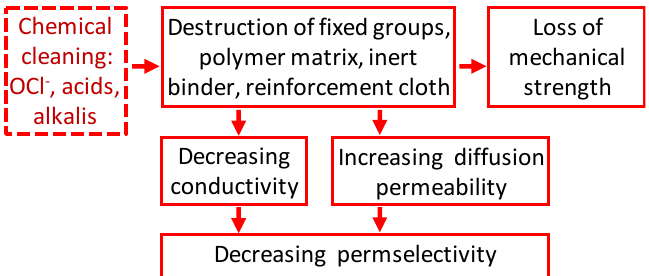
Figure 1. Influence of traditional chemical cleaning on the structure, mechanical strength and transport characteristics of ion-exchange membranes.